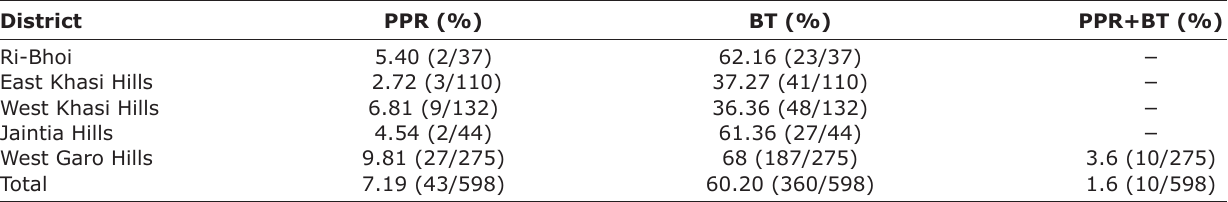
Table-1: Percent seropositivity of PPR and BT in five districts of Meghalaya. District PPR